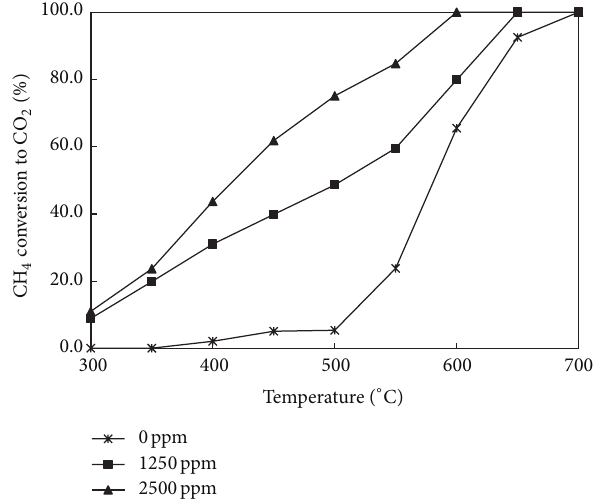
Figure 4: Effect of NO content on CH 4 conversion to CO 2 over In/HZSM-5/In 2 O 3 . Feed gas: 2.0% O 2 , 0.2% CH 4 , and the balance of H; GHSV = 3600 h −1